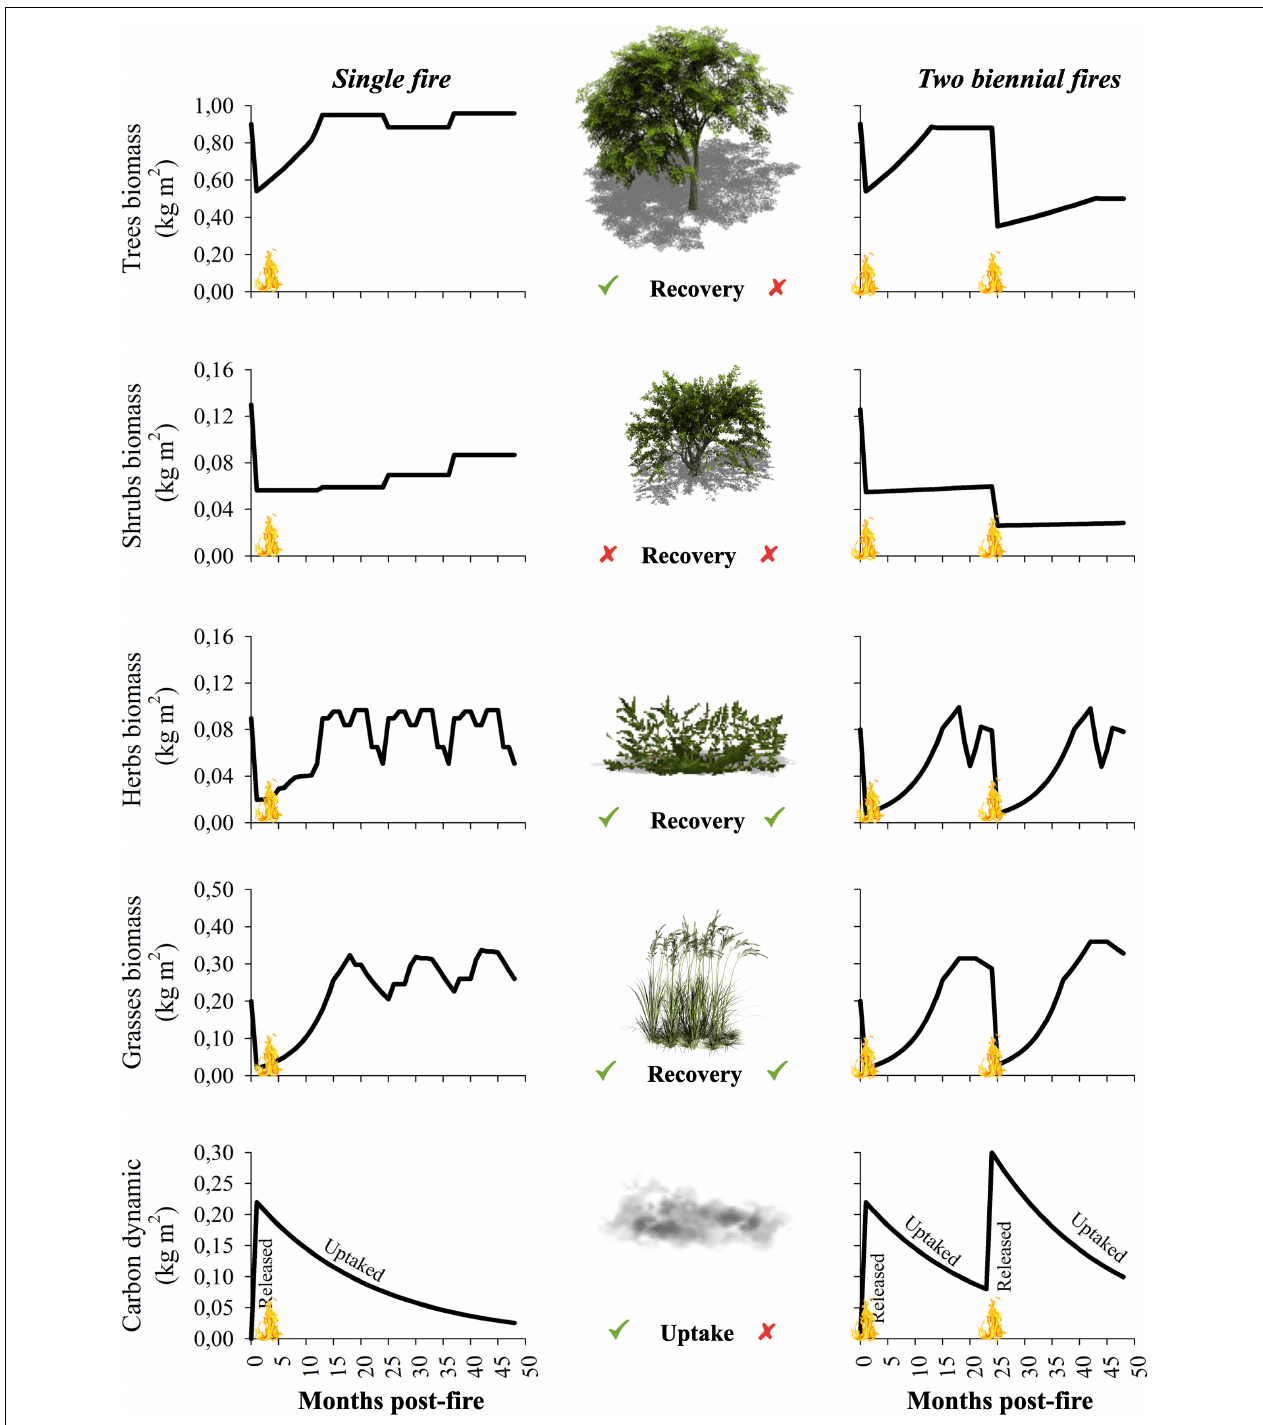
FIGURE 3 | Post-fire recovery simulations for biomass of trees, shrubs, herbs, grasses, and atmospheric carbon dynamic (uncommitted emissions) for the Brazilian savanna, using the BEFIRE model. (cid:88) = Yes; x = No (online version in color).